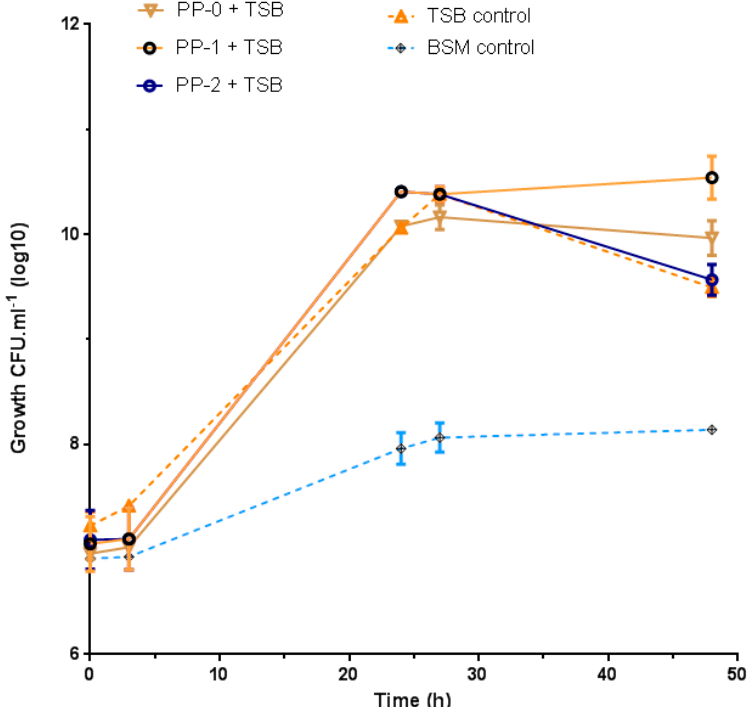
Figure 4. The shake flask experiments of C. necator in growth nitrogen-rich tryptone soya broth (TSB) media, with polypropylene (PP) 0 to 2) and basal salts media (BSM) and TSB only controls for comparison. The experiments were conducted over a 48 h period at 150 rpm. Each point is an arithmetic mean of triplicates, while error bars denote the SE of the mean.